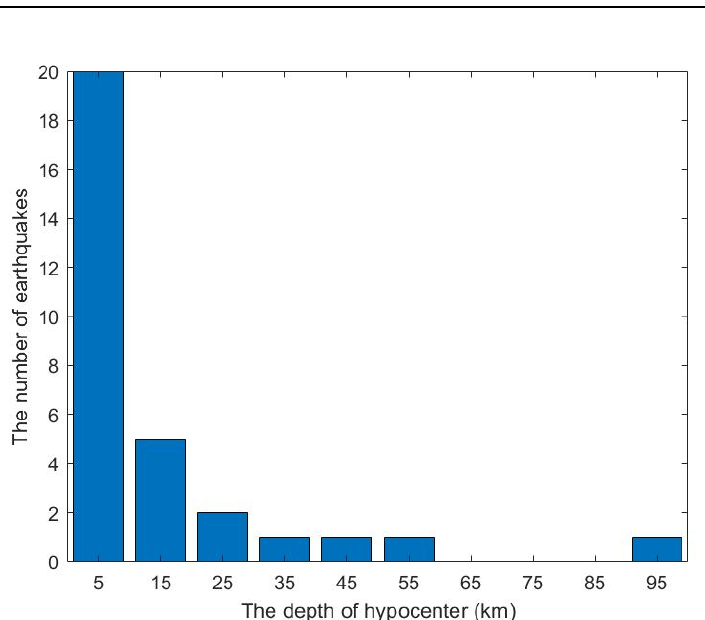
Figure 1. The epicenters in China and the surrounding area from 2020 to 2021.